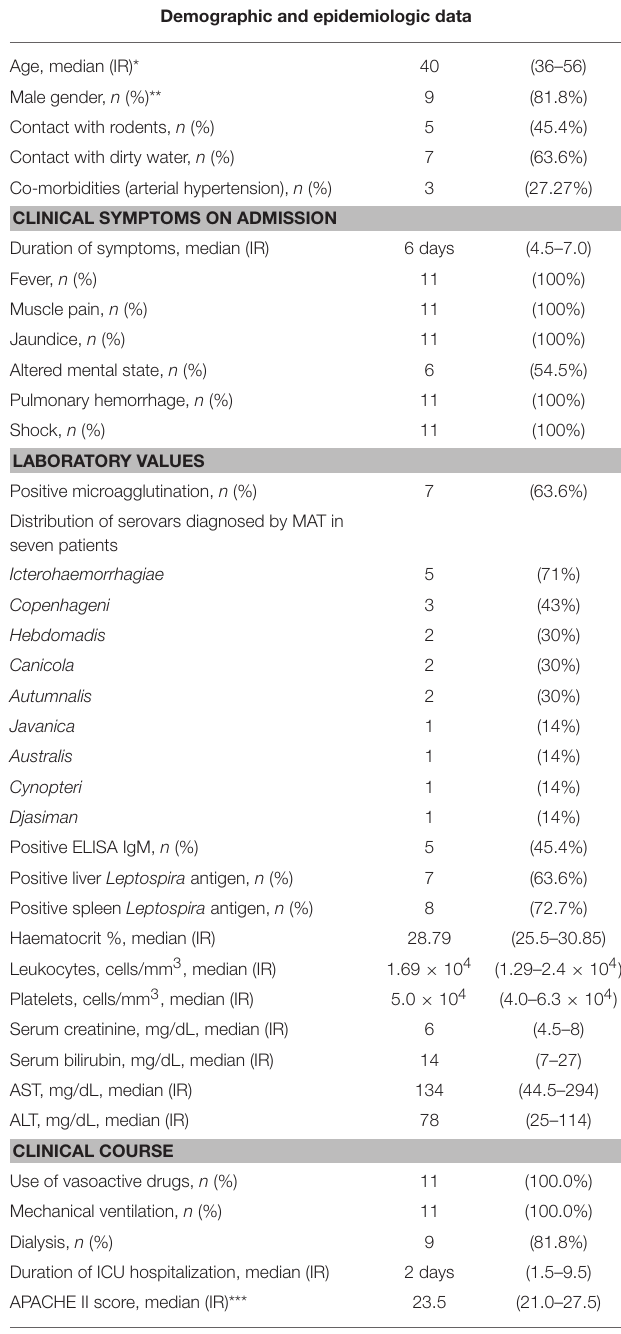
TABLE 2 | Antibody information. TABLE 3 | Clinical and laboratory findings of 11 patients with severe leptospirosis with severe pulmonary hemorrhage syndrome and shock. Demographic and epidemiologic